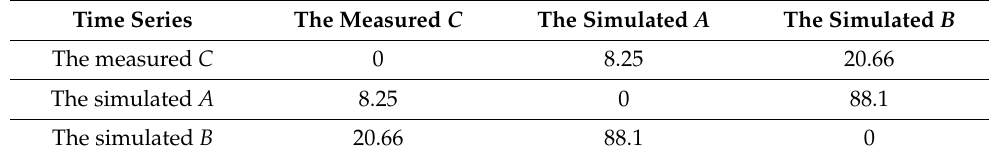
Table 7. Dynamic time warping distance calculation results (calculation period [0,